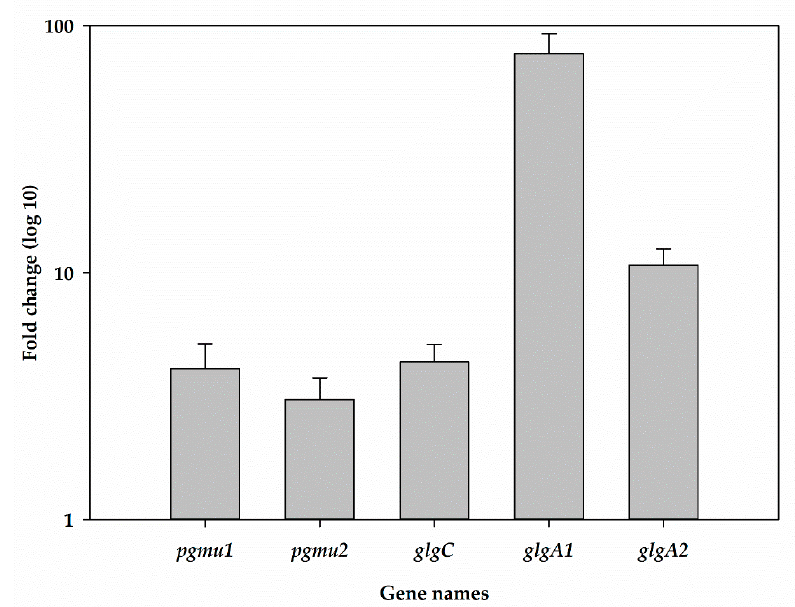
Figure 3. Relative levels of transcripts of genes involved in glycogen synthesis in Synechococcus sp. BDU 130192 compared to Synechococcus sp. PCC